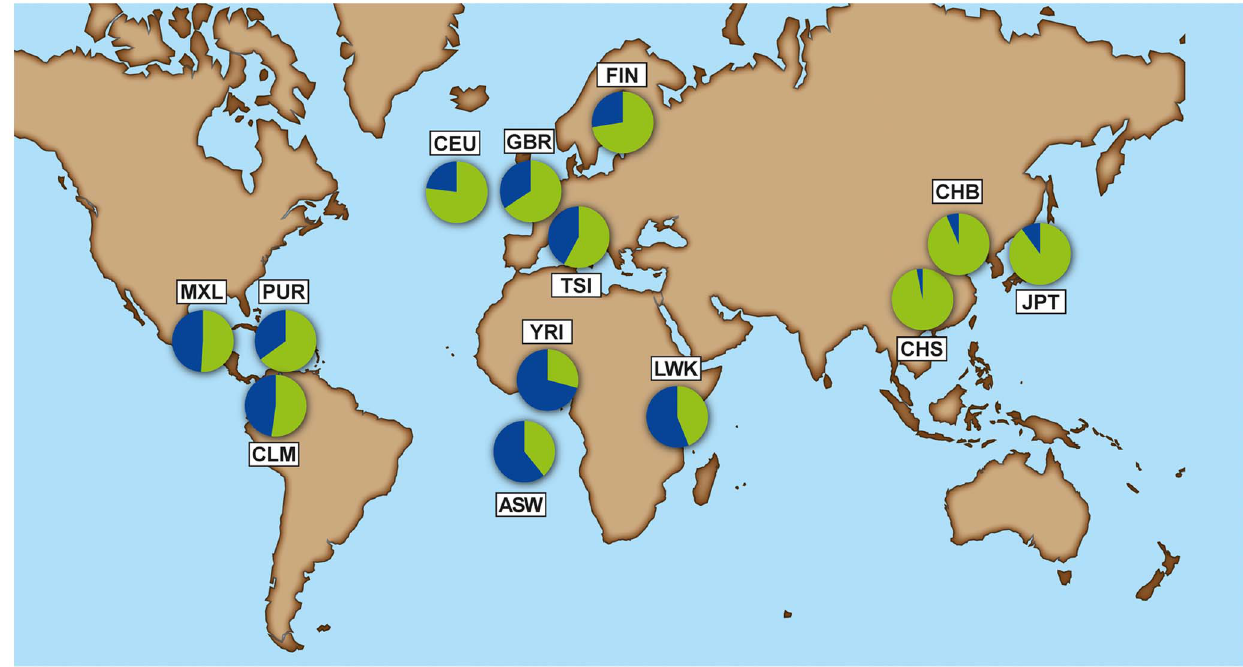
Figure 2. Allele frequency of rs368234815 - D G allele (blue) and TT allele (green) for each population from the 1000 Genomes dataset. American populations of European and African origin (CEU, ASW) are placed near the geographic area of origin. For full population names see Methods.